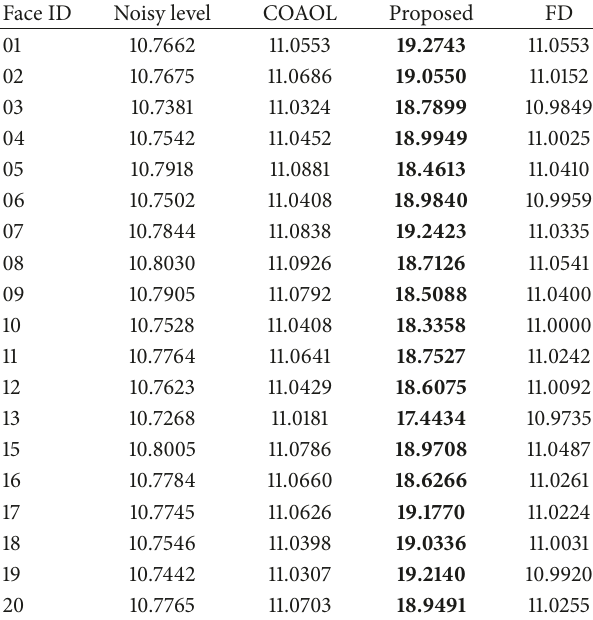
Table 1: Image denoising performance of PSNR